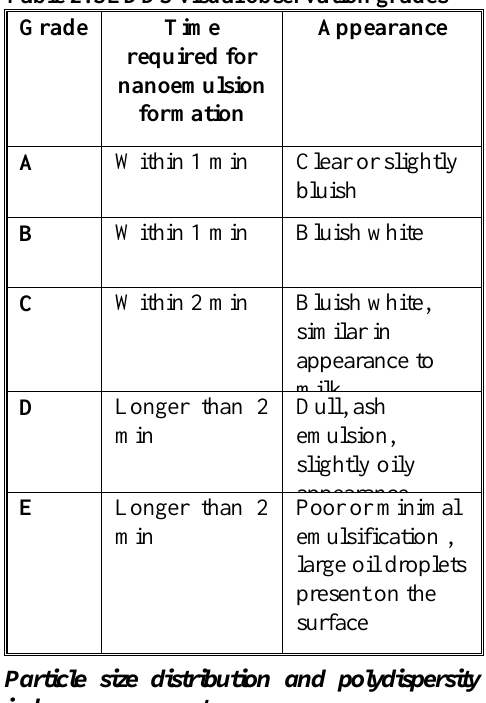
Table 2. SEDDS visual observation grades